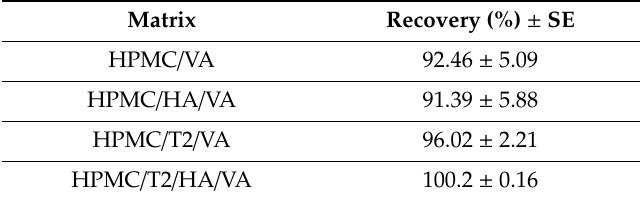
Table 5. VA recovery of the formulations under study (Mean ± SE, n =